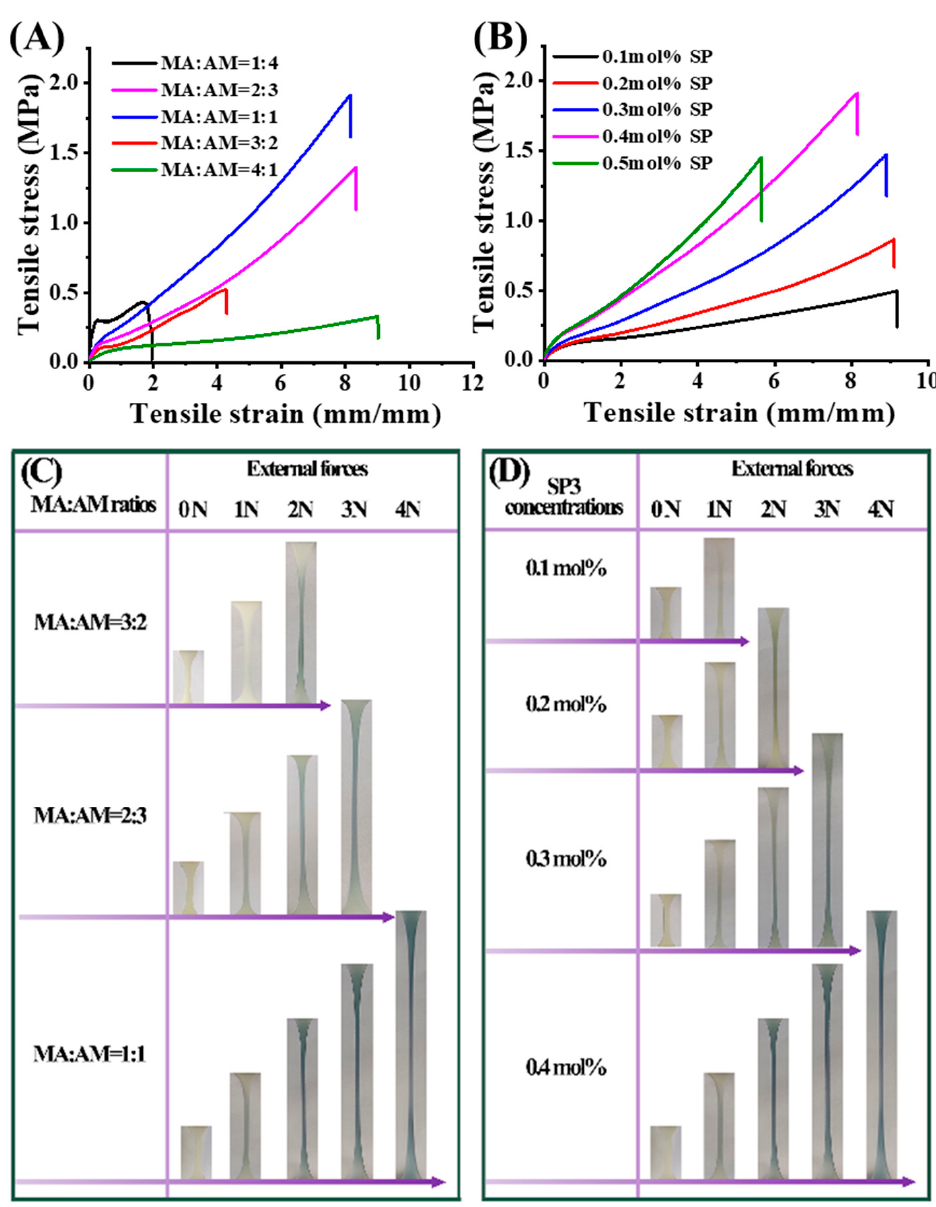
Figure 5. Mechanical and mechanoresponsive properties of the as-prepared poly(AM– co – MA/DMSP3) hydrogels with different MA:AM ratios and DMSP3 concentrations: ( A , B ) tensile stress–strain tests; ( C , D ) their corresponding color change in response to the external force. Due to the elastomer-like mechanical property and reversible transition of SP ↔ MC in DMSP3 moiety, the AM 25 –DMSP3 0.4 –MA 25 hydrogels were expected to have mechanical and mechanoresponsive self-recovery properties. To demonstrate the self-recovery prop- erties of the hydrogels, loading and unloading experiments were performed on the AM 25 – DMSP3 0.4 –MA 25 hydrogels with a maximum tensile strain of λ = 3. For comparison, the out continuously without any rest period, while the third–fifth tests (i.e., third, fourth, and fifth-recovery) were conducted on the gels with 5, 10 and 30 min, respectively, for recov- ery during the unloading process. For each loading–unloading cycle, the hydrogel strip was spontaneously recovered to its original length without additional treatment. The me- chanical recovery was estimated by cyclic stress–strain curves (Figure 6A), and the stiff- ness/toughness recovery ratios were summarized in Figure 6B. As shown in Figure 6A, the AM 25 –DMSP3 0.4 –MA 25 hydrogels showed the largest hysteresis loop in the first origi- nal cycle, and the hysteresis loop became much smaller in the second no recovery cycle. Nevertheless, the hysteresis loop became larger with increasing the resting time in the third–fifth cycles. Quantitatively, the stiffness/toughness recovery of hydrogels after the